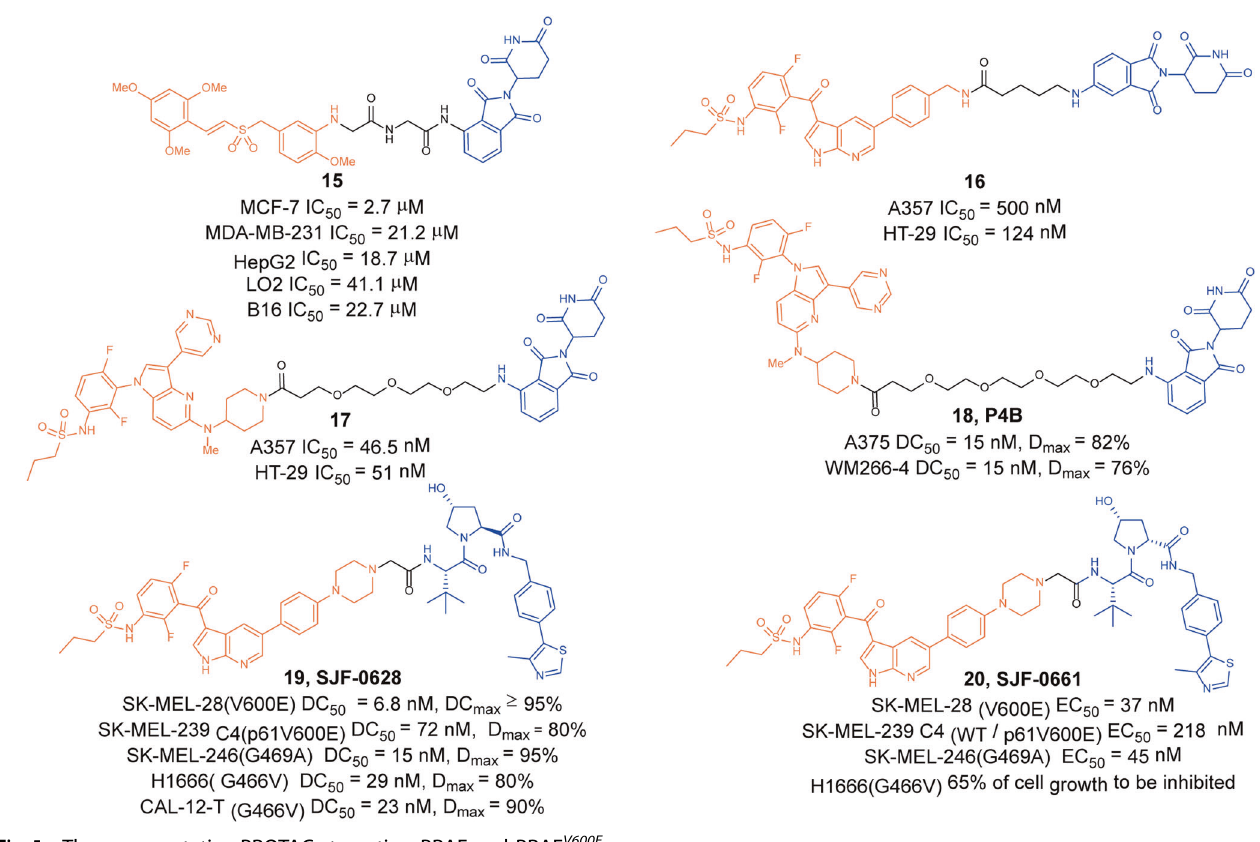
Fig. 5 The representative PROTACs targeting BRAF and BRAF V600E